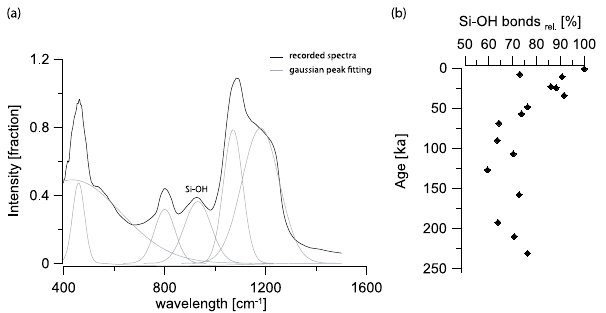
Fig. 4. Assessment of potential diagenetical changes. (a) gaussian peak fitting and peak centres for all silica modes, the Si-OH bond peak is located at about 945cm − 1 . (b) FTIRS analysis of 16 sam- ples